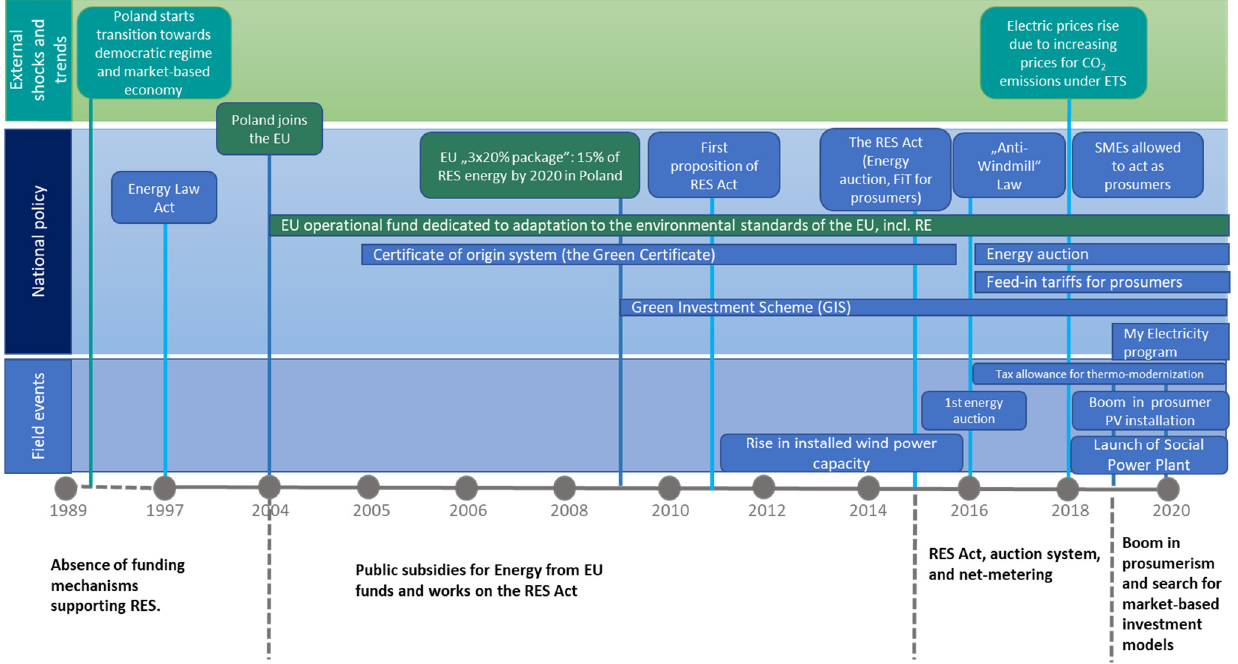
Figure 1. Subsidies and financing of renewable energy sources in Poland in the years 1989–2020. Reproduced from [13], Iskandarova, M. et al.: 2021